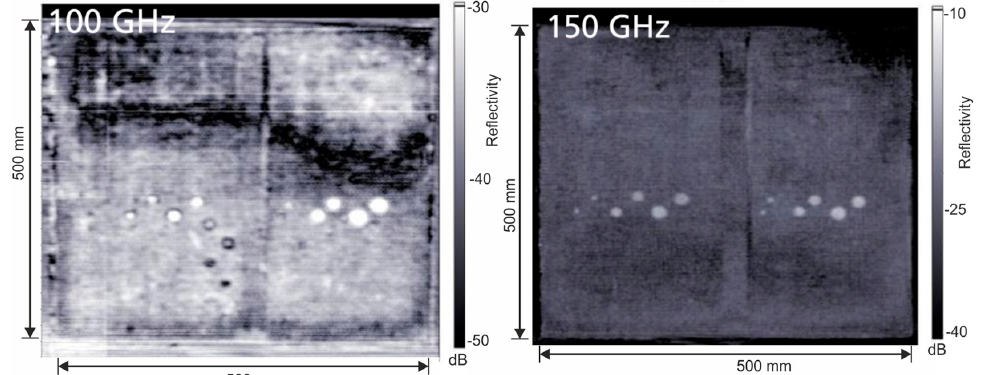
Figure 2. Terahertz images of the test sample shown in Figure 1. The measurements were performed with two individual sensors operating at ( left ) 100 GHz and ( right ) 150 GHz with modulation bandwidths of 40 and 60 GHz, respectively. The images show a cross-sectional view of the sample at the same depth around the center of its thickness. The 100 GHz measurement provides a larger penetration depth, while on the other hand, the 150 GHz measurement provides a larger spatial and depth